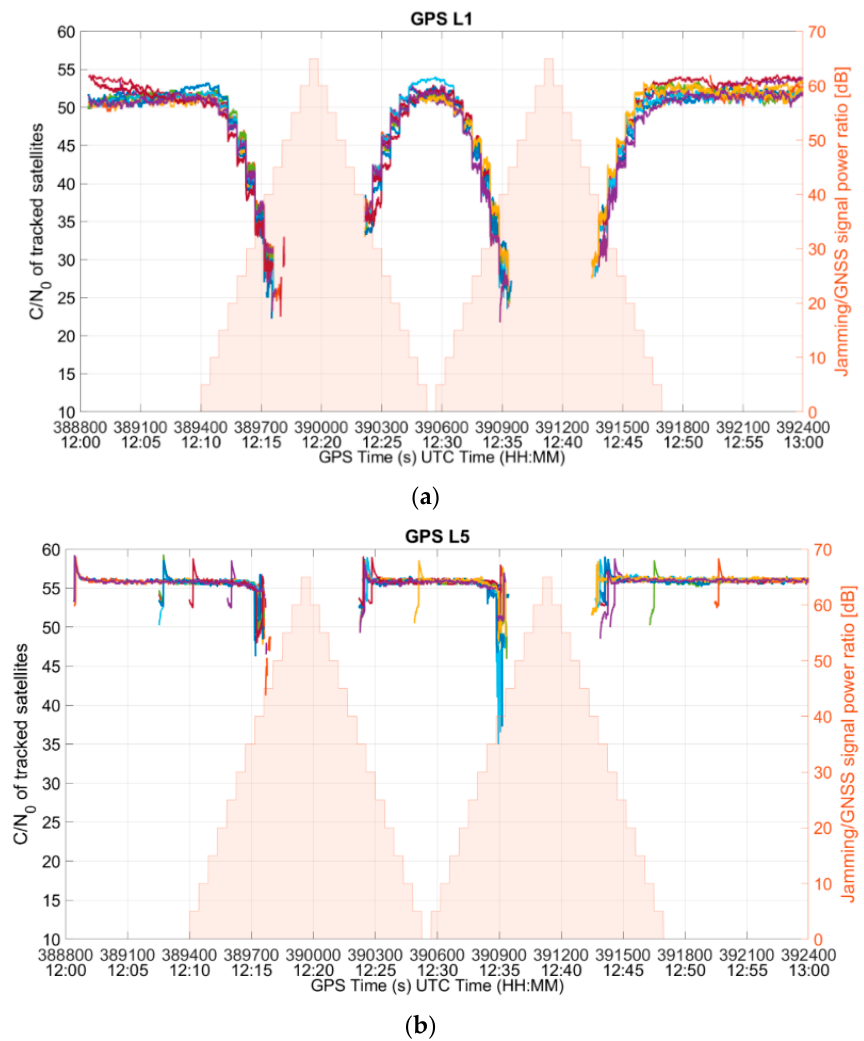
Figure 11. C/N 0 of ( a ) GPS L1, and ( b ) GPS L5 tracked satellites.